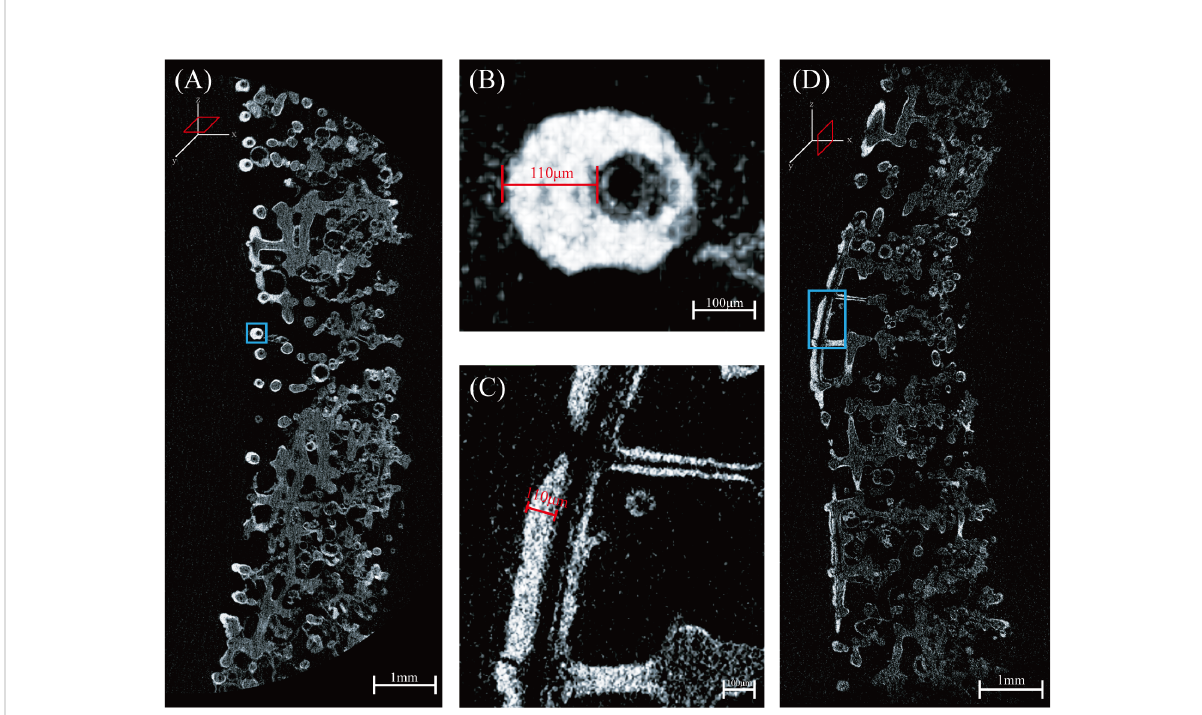
FIGURE 3 Three-dimensional cross sectional micro-computed tomography scan images of FMP: (A) and (D) are images scanned in the xy and yz scanning axes, respectively, and (B) and (C) are enlarged images of (A) and (D) , respectively. Bright areas indicate ferromanganese oxide with a thickness of approximately 110 m m.